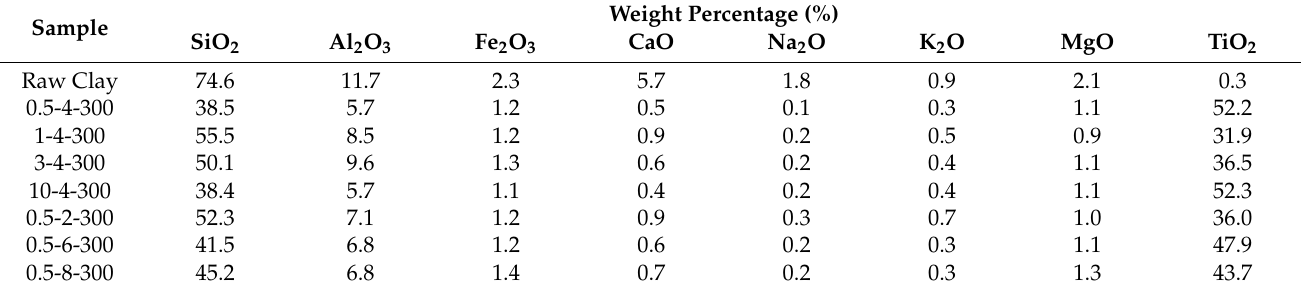
Figure 12. XRD patterns of Ti-pillared clays prepared under different operating conditions in comparison with the raw clay; effect of ( a ) clay suspension concentrations, and ( b ) H + /Ti ratio, AT: Anatase TiO 2 ; RT: Rutile TiO 2 ; Q: Quartz (SiO 2 ); M: Montmorillonite; C: Calcite. Table 4. Chemical composition of natural bentonite and Ti-Pillared bentonite prepared under different operating